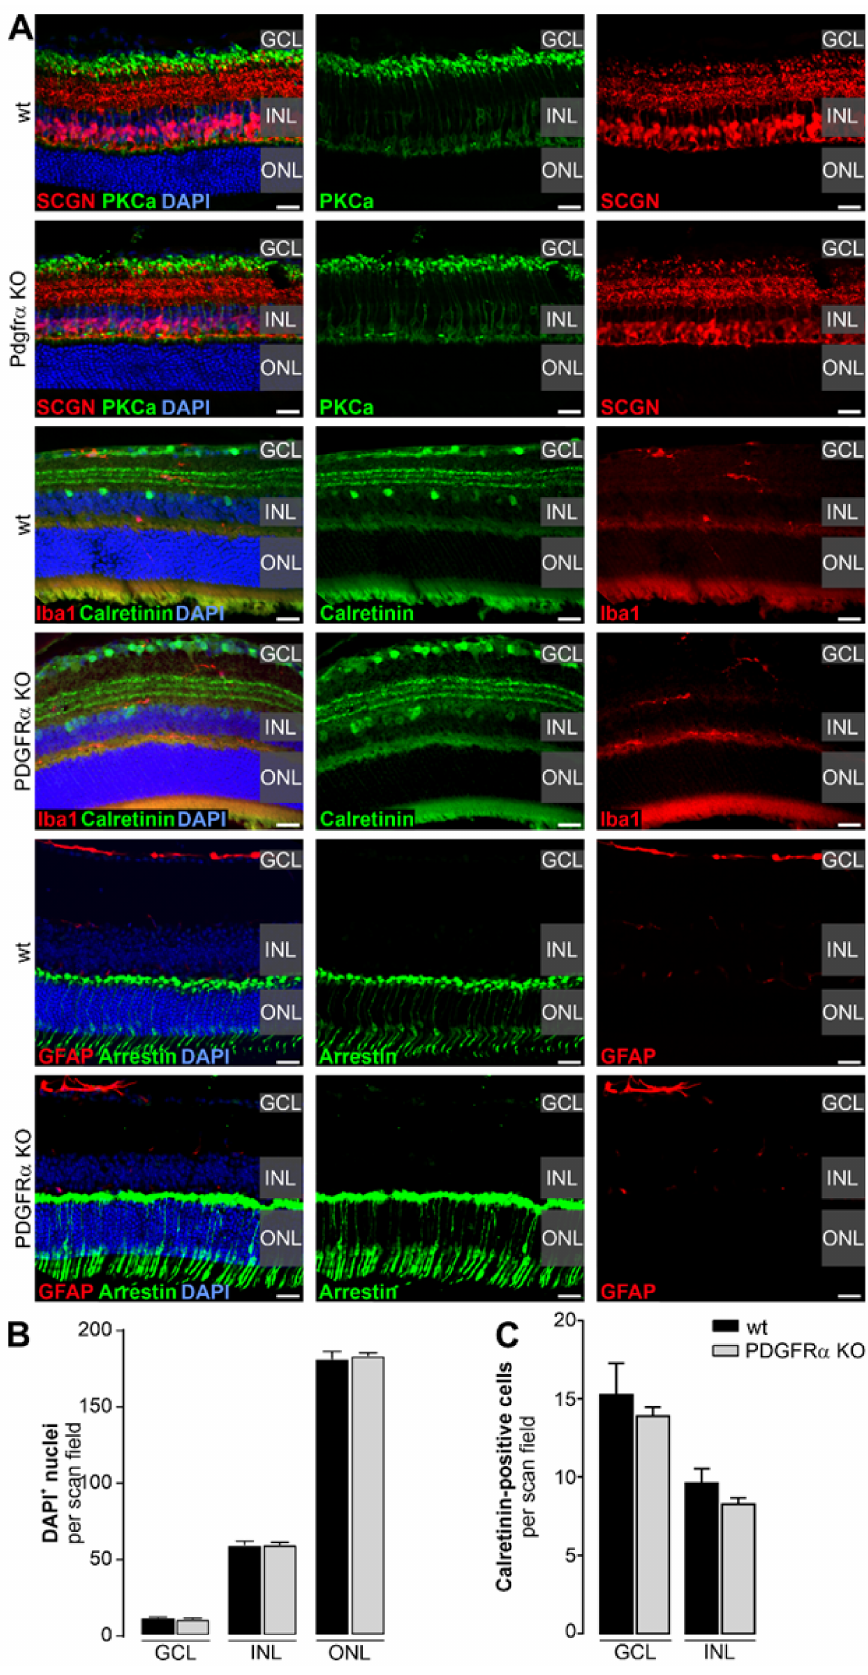
Figure 2. Characterization of retinal architecture in Müller cell-specific PDGFR α KO mice. ( A ) Various retinal cell types in Müller cell-specific PDGFR α KO mice were characterized